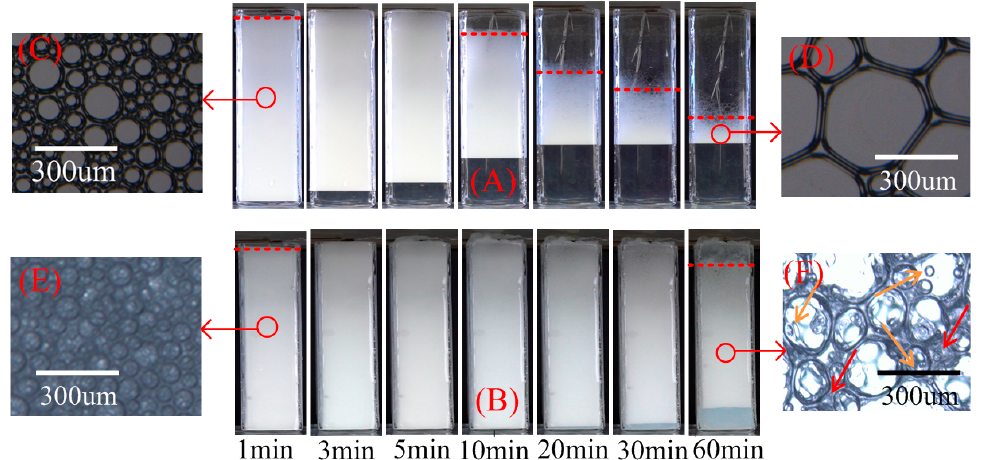
Figure 4. Process of foam decay and drainage under T = 200 ◦ C: ( A ) XG-0#, ( B ) XG-4#, ( C,E ) foam morphology at zero, ( D,F ) foam morphology at 60